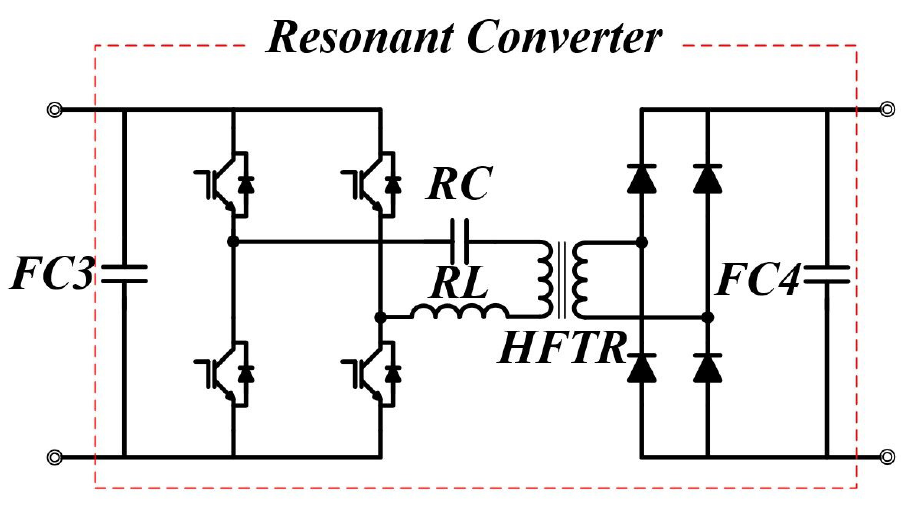
Figure 8. Part of resonant converter.